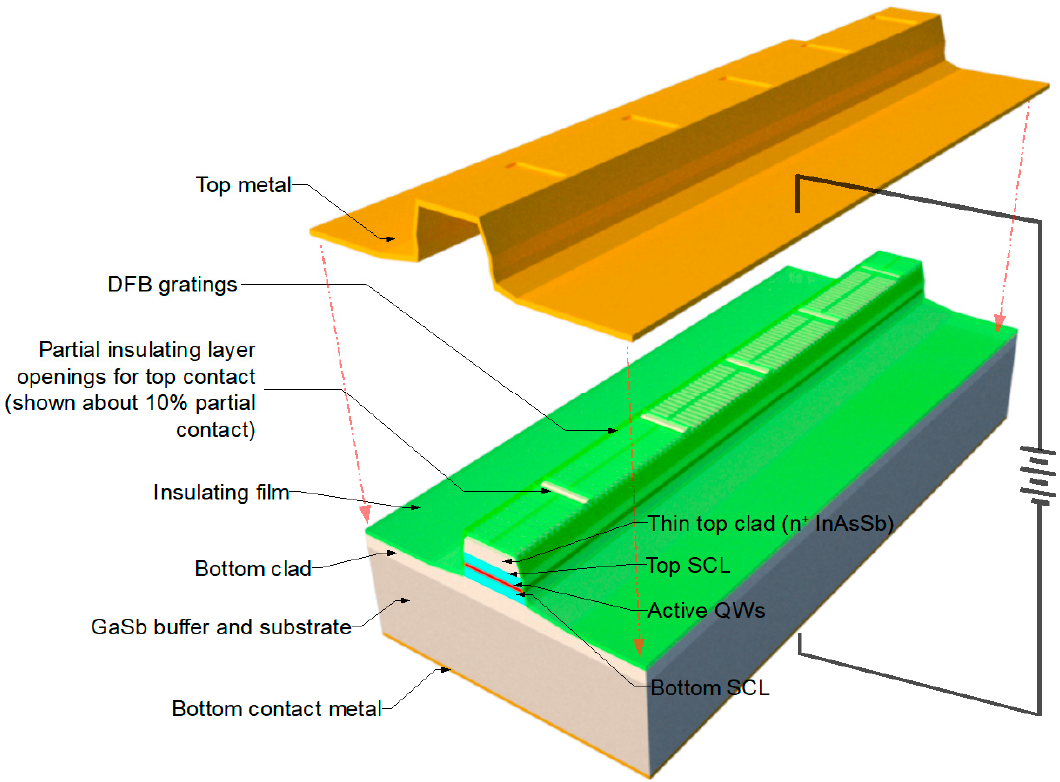
Figure 14. Schematic of a DFB ICL with low-fill-factor top contact. Dimensions such as the ratio of contact period to total cavity length are not to scale.